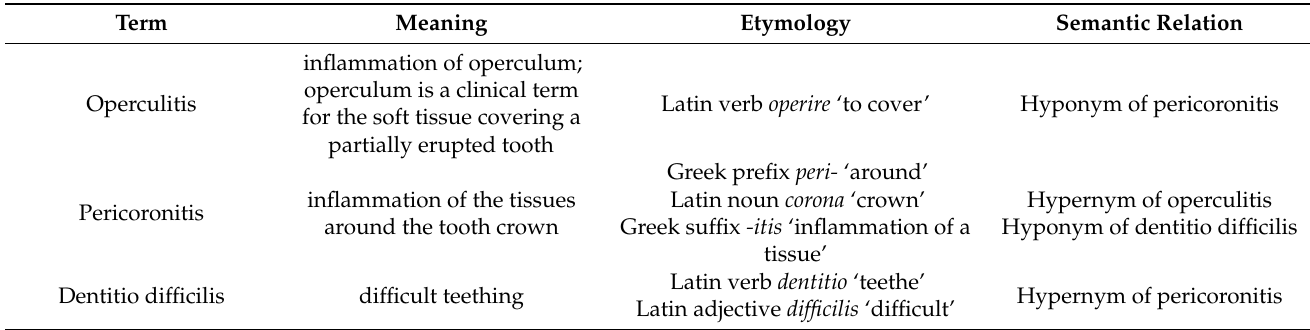
Table 1. Terminology. Table 1 explains clinical terms associated with inflammation of soft tissues around erupting or imperfectly erupted teeth, etymology, and semantic